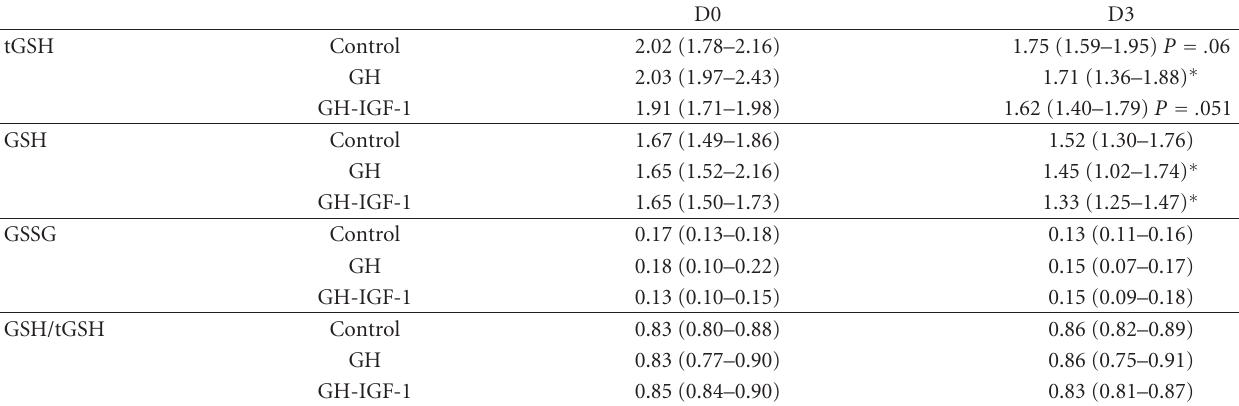
Table 7: Glutathione concentrations and redox-status of glutathione in skeletal muscle (mmol(kg ww muscle)). Total glutathione (tGSH), reduced glutathione (GSH), oxidized glutathione (GSSG), and the redox-status of glutathione (GSH/tGSH).